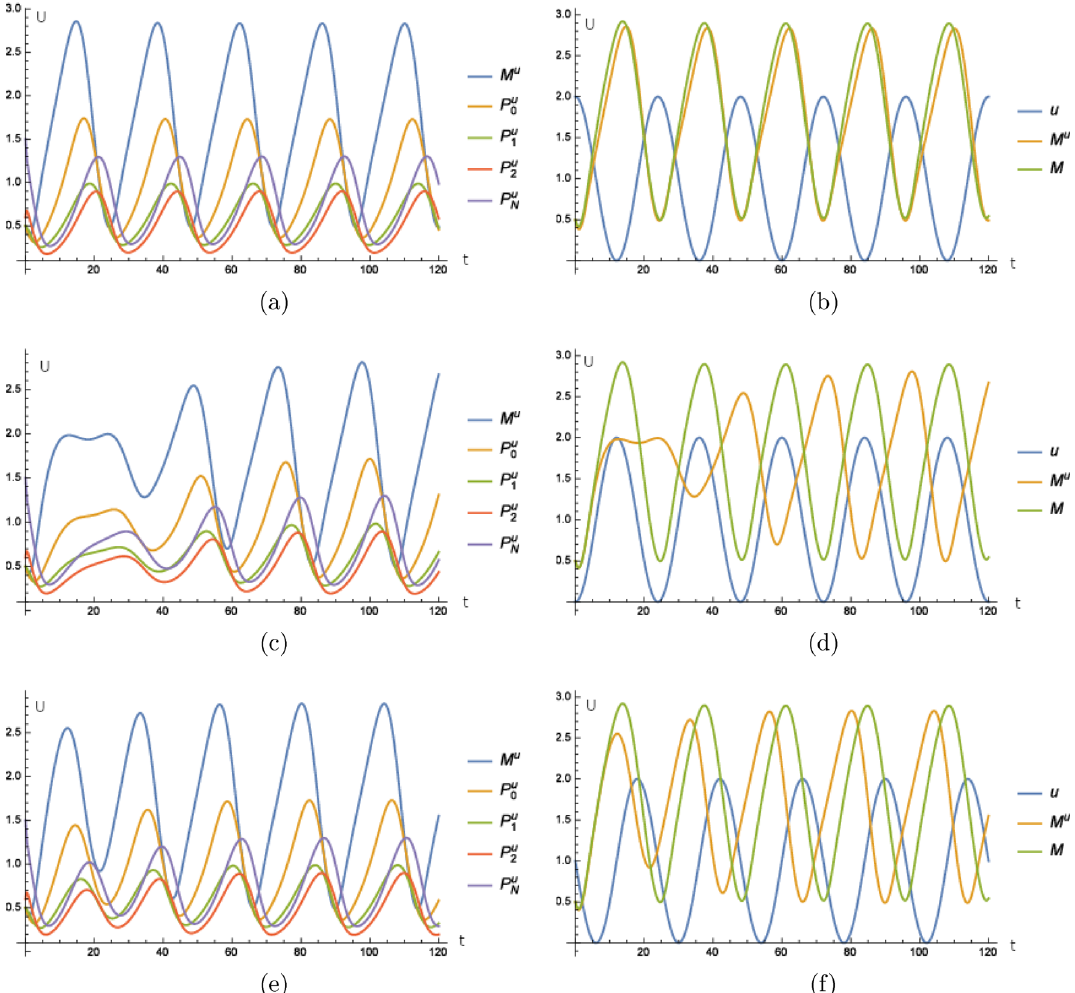
Figure 2. The model of Goldbeter including our extension does not differ from the original model of Goldbeter if the molecular clock is in the phase of the external Zeitgeber. ( a ) Time curves where the superscript u indicates that these time curves stem from the extended model consisting of (6) and (2) to (5) with (7) for ϕ = 0 and α = 0.05 . ( b ) Time curve of the external stimulus u defined in (7), of M calculated from the model (1) to (5) and of M u calculated from (6) and (2) to (5) with (7) for ϕ = 0 and α = 0.05 . For the figure ( c ) and ( d ) the external stimulus induces a shift of the molecular clock’s phase of 12 h where the experiment is as in ( a ) and ( b ) but with ϕ = π . The external stimulus induces a shift of the molecular clock’s phase of about 6 h in ( e ) and ( f ) where the experiment is as in ( a ) and ( b ) with ϕ = π 2 . Units and and dimensions: abscissa t : time in hours, ordinate U : amount of substance ( M , M u mRNA, P u i , { 0, 1, 2, N } , protein, u intensity of